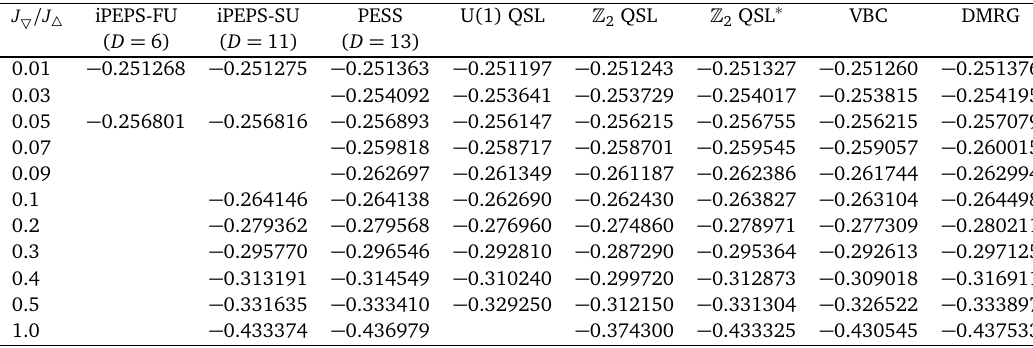
Table 1: Variational energies obtained from iPEPS and PESS compared with U(1), (cid:90) QSL and VBC energies of Ref. [ 42 ] and DMRG data of Ref. [ 44, 58 ] for YC8-2 2 cylinder geometry. (cid:90) QSL ∗ is an improved RVB ansatz [ 59 ] . The lowest possible 2 energies for all couplings belong first to the DMRG results and next to our PESS ( D = 13)